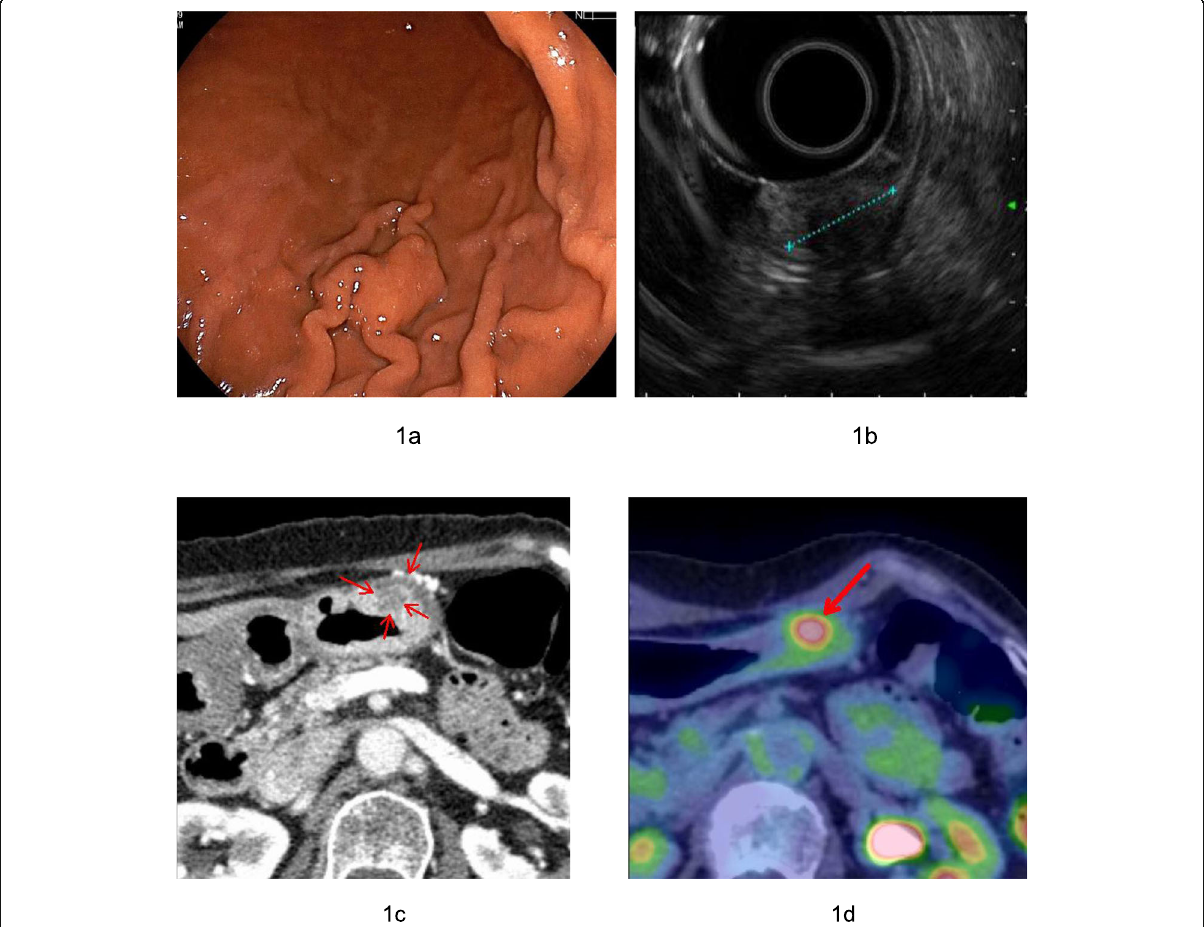
Fig. 1 a Upper gastrointestinal endoscopy shows an elevated lesion in the greater curvature of the lower part of the stomach with no abnormalities of the gastric mucosa. b Endoscopic ultrasonography shows that the tumor is a low-echoic 10-mm lesion derived from the submucosal layer of the stomach. c Enhanced computed tomography shows a 15-mm hypovascular tumor in the greater curvature of the lower part of the stomach (arrows). d F-fluorodeoxyglucose (FDG) positron emission tomography shows an FDG uptake with an SUV max of 3.8 – 5.1